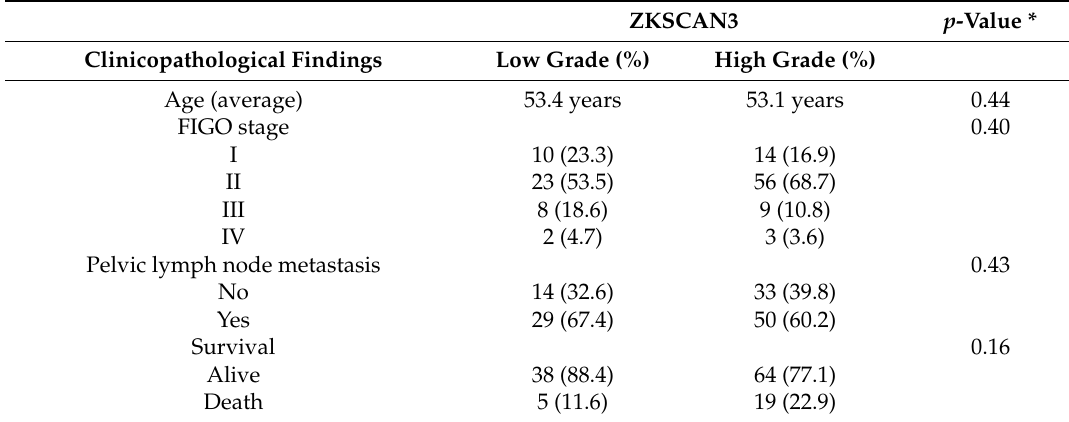
Table 2. Expression of ZKSCAN3 in cervical cancer: correlation with the clinicopathological